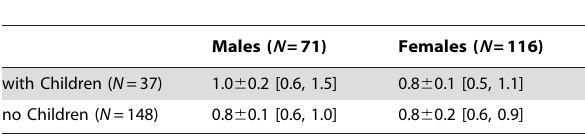
Table 4. PDRs research output in relation to the presence or absence of children: mean 6 standard error and 95% confidence interval (brackets).